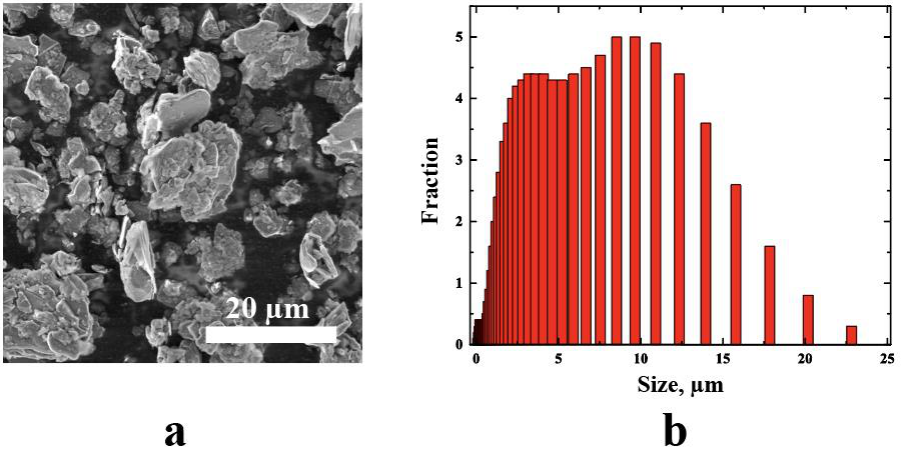
Figure 1. ( a ) SEM image of hBN particles, and ( b ) particle size distribution (PSD) histogram.